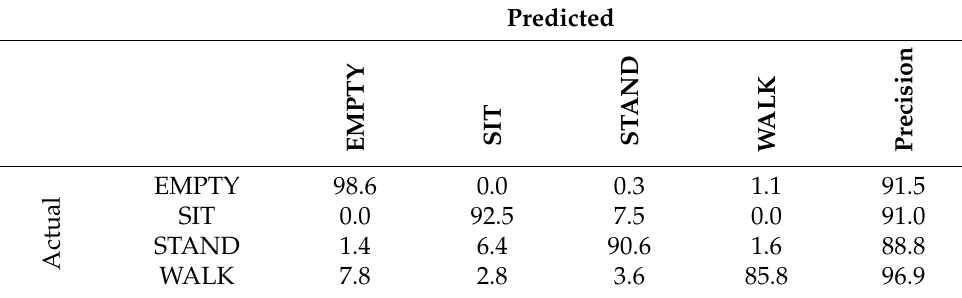
Table 4. LSTM HAR classification with feature matrix for Experiment 1.1.